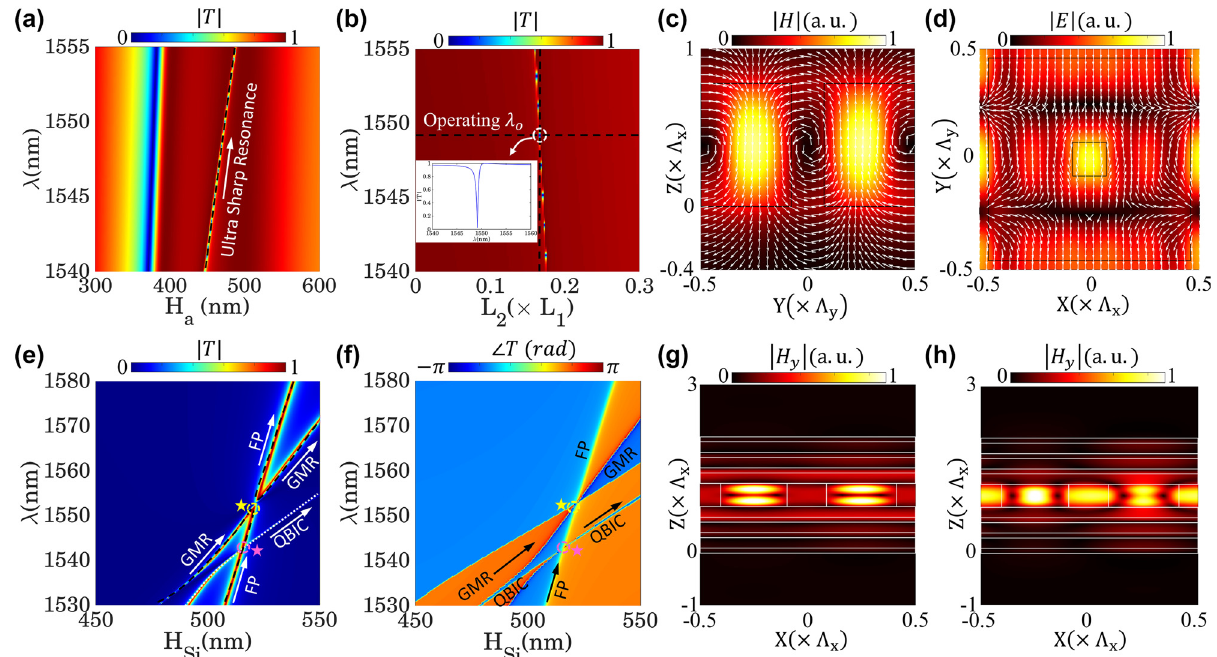
Figure 2: Transmission response of the static metasurface. The optical response of the ultrahigh-Q static metasurface with respect to the = 1540 nm to 𝜆 = 1555 nm when (a) the thickness of the nanocuboids and (b) the length change in the operating wavelength ranging from 𝜆 1 2 = 554 nm, L = 0.17 × L = 471 nm, , H of the hollow region are varying. By fixing the structural topology of the consisting elements to be L 1 2 1 a and P = 603 nm, the optical response of the metasurface will demonstrate an extremely narrowband filtering in the transmission mode as it is shown in the inset of panel (b). The near-field distribution of (c) magnetic and (d) electric field within the unit cell in the (Y–Z) and (X–Y) plane, respectively. The calculated transmission (e) amplitude and (f) phase of the temporal platform as functions of its consisting elements thicknesses and operating wavelength. Increasing the height of the resonators leads to two sets of spectral overlaps between (FP-GMR) and (FP-QBIC) resonance modes. The corresponding magnetic field distributions of (g) FP and (h) GMR modes in the ( X – Z )